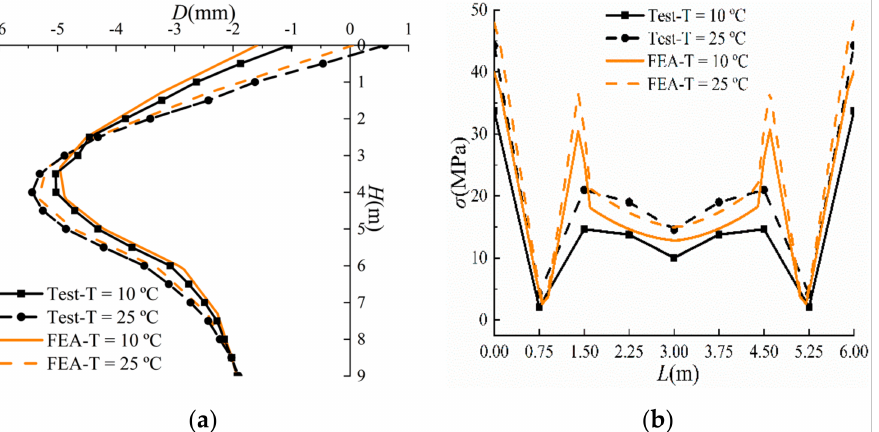
Figure 20. Comparison between the measured and simulated values: ( a ) The horizontal displacement of pile 3; ( b ) the stress on waist beam